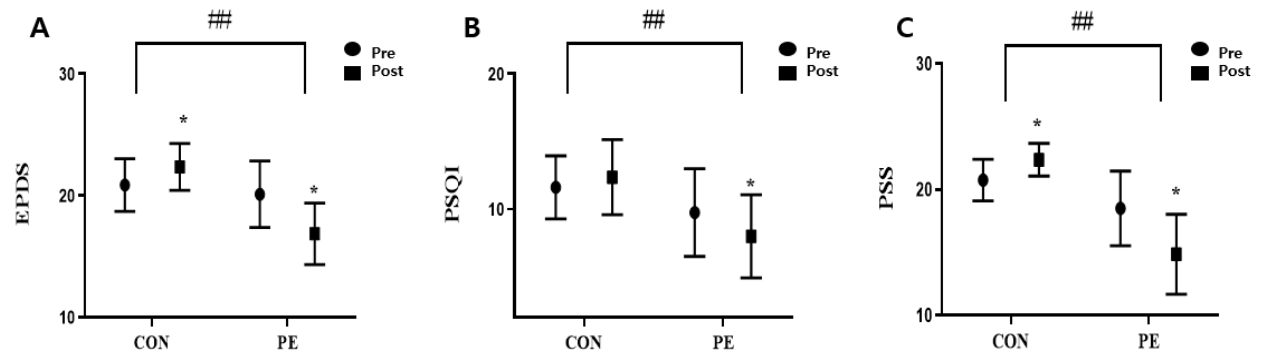
Figure 3. Effect of EPDS ( A ), PSQI ( B ), PSS ( C ) according to Pilates. Bars represent mean ± SD (CON: n = 8, PE: n = 8). * p < 0.05 from pre to post. ## p < 0.01 change (post–pre) between groups.